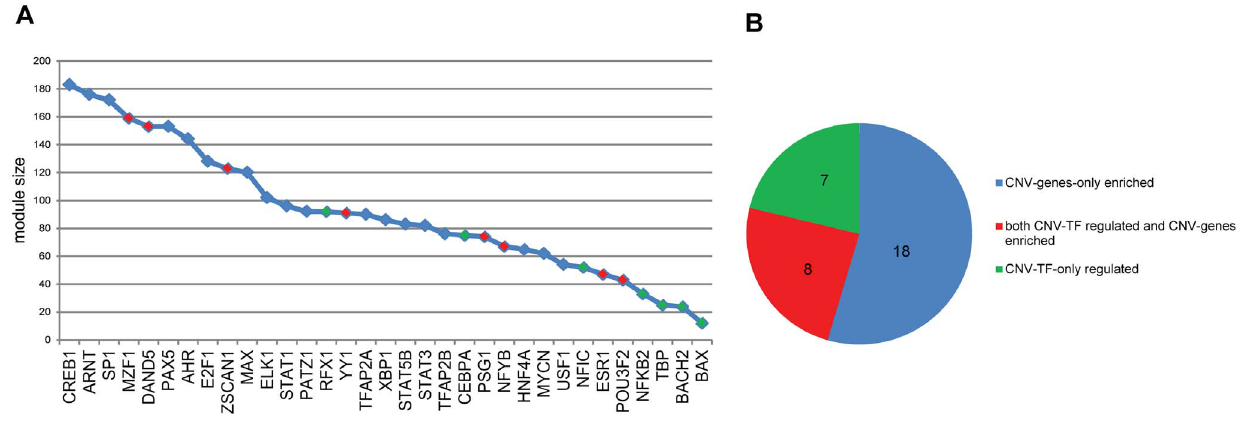
Figure 2. Overview of module subtype and size in CNV-ICC-TRN. In both A and B figures, blue color represents CNV-gene-only enriched module, green color represents CNV-TF-only regulated module, red color represents both CNV-TF regulated and CNV-gene enriched module. doi:10.1371/journal.pone.0098653.g002 PLOS ONE |